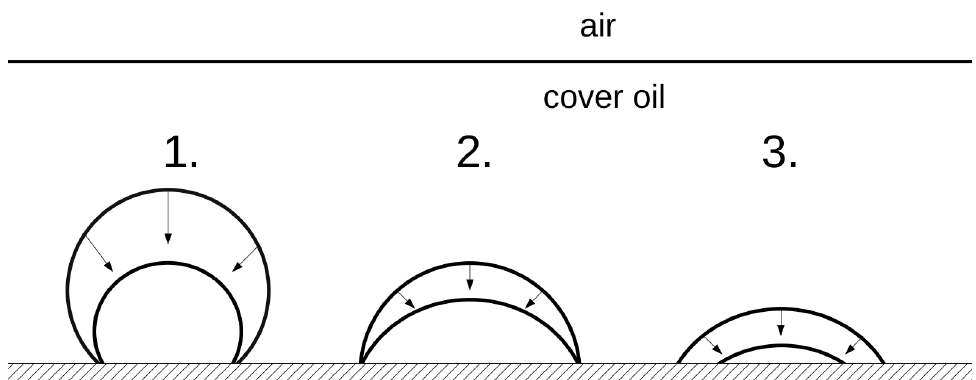
Figure 5. 3 phase model of sessile droplet dissolution under a cover oil on a hydrophobic surface. Phase 1: The contact angle decreases together with the droplet diameter, while the contact area remains unchanged. Phase 2: After the contact angle reaches 90 ◦ , it keeps decreasing together with the volume of the droplet but with a constant contact diameter. Phase 3: The contact diameter and the contact angle decrease at the same time until complete disappearance of the droplet.